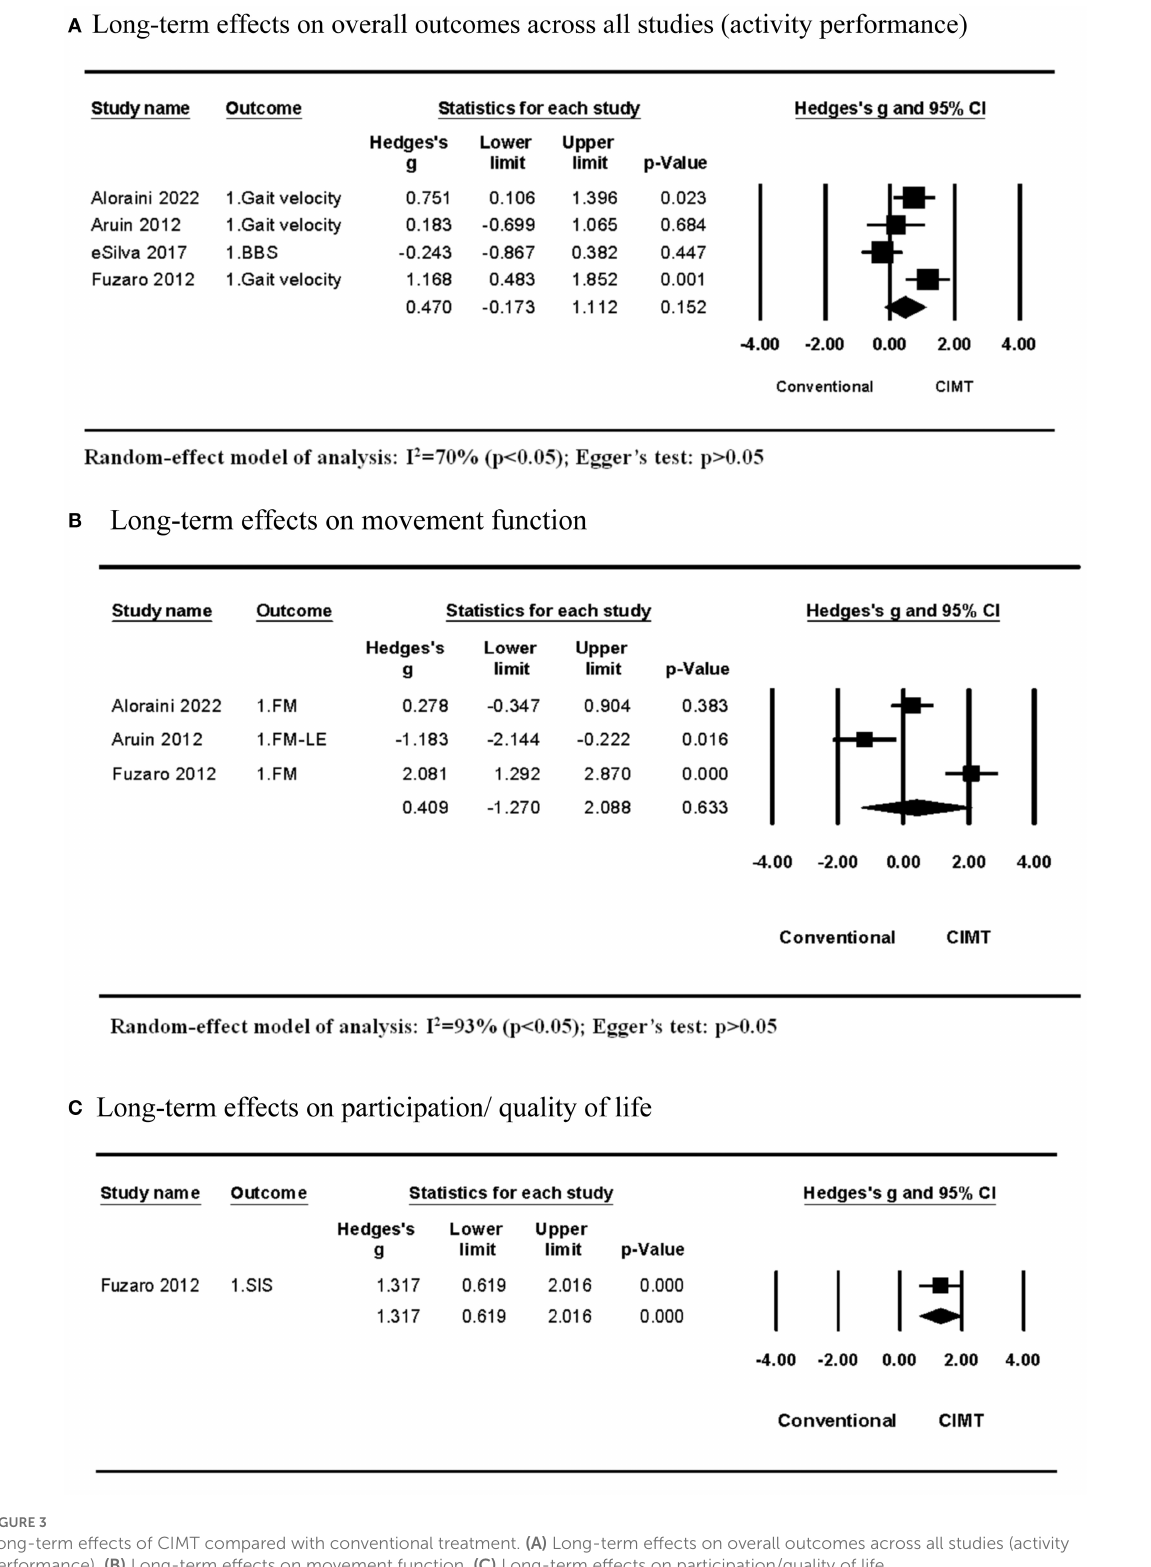
FIGURE3 Long-term effects of CIMT compared with conventional treatment. (A) Long-term effects on overall outcomes across all studies (activity performance). (B) Long-term effects on movement function. (C) Long-term effects on participation/quality of